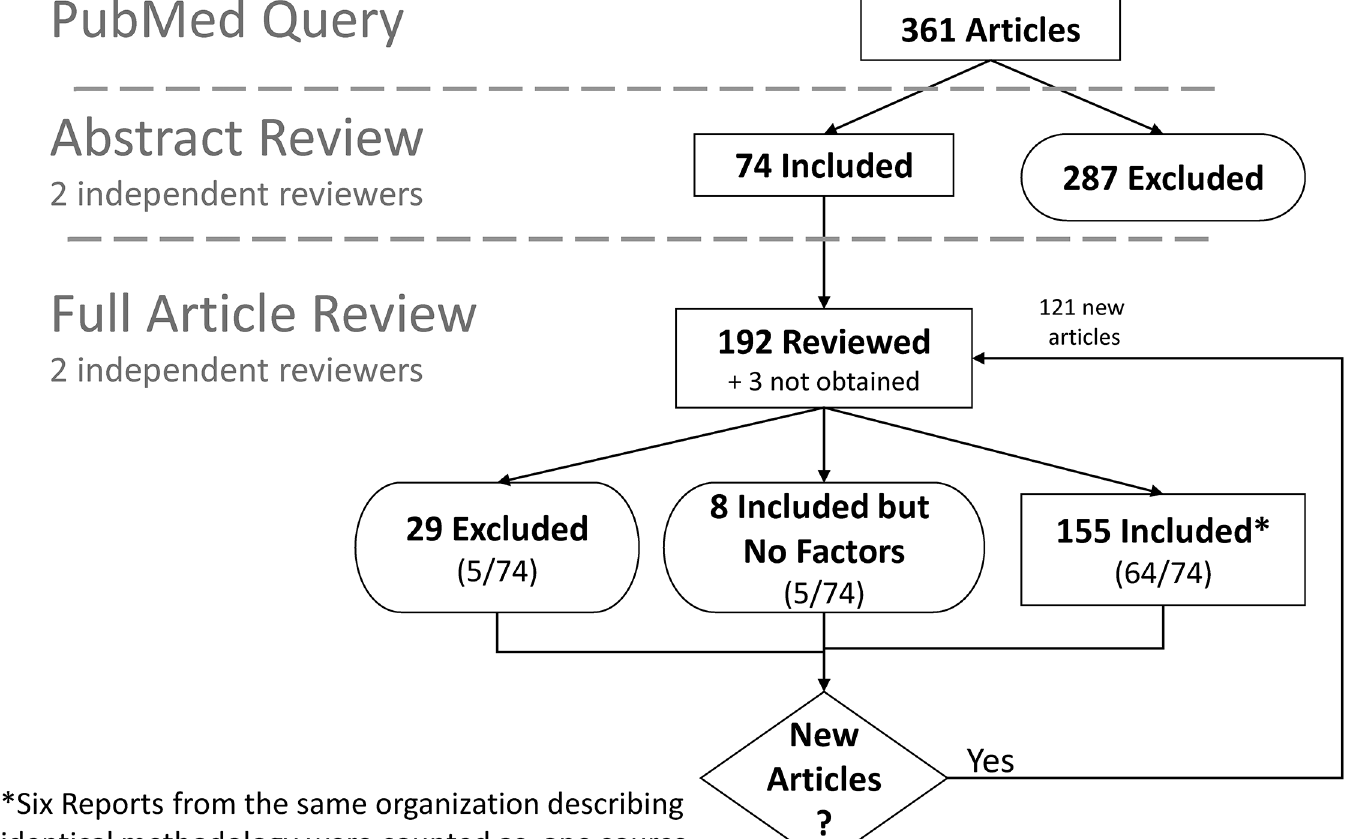
Fig 2. Disposition of screened